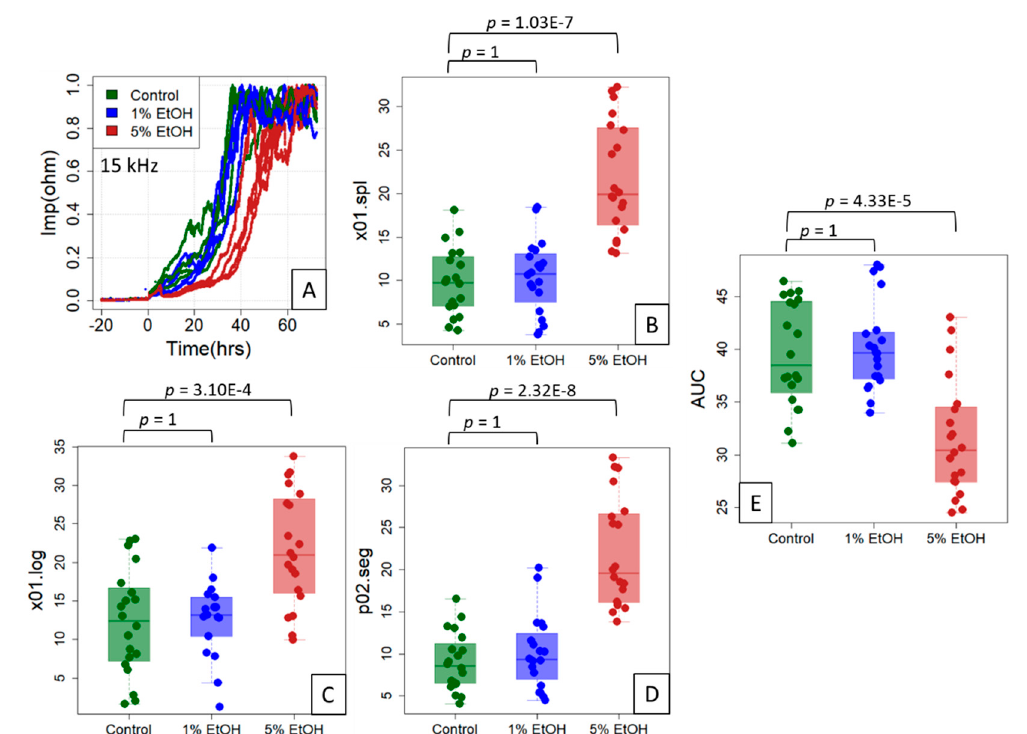
Figure 5. Reference points for the ethanol treatment experiment on IPEC-J2 cells. The cells were untreated (control) or treated with 1% or 5% ethanol (EtOH) (typical data shown in ( A )) in an experimental setup of five independent experiments of four replicates each. Using the three location indices “Time at 10% spline” (x01.spline; ( B )), “Time at 10% logistic fit” (x01.log; ( C )) and “Time at 20% segmented regression” (p02.seg; ( D )) on (0, 1)-normalized data (inset), a clear right shift of the impedance curve at 5% ethanol is evident. ( E ) The area under the curve (AUC) estimates of the complete time scale for all 20 replicates. A Welch (unequal variance) t -test, Bonferroni-corrected for multiple testing, was used to obtain p -values for the two group comparisons, control/1% EtOH and control/5% EtOH.